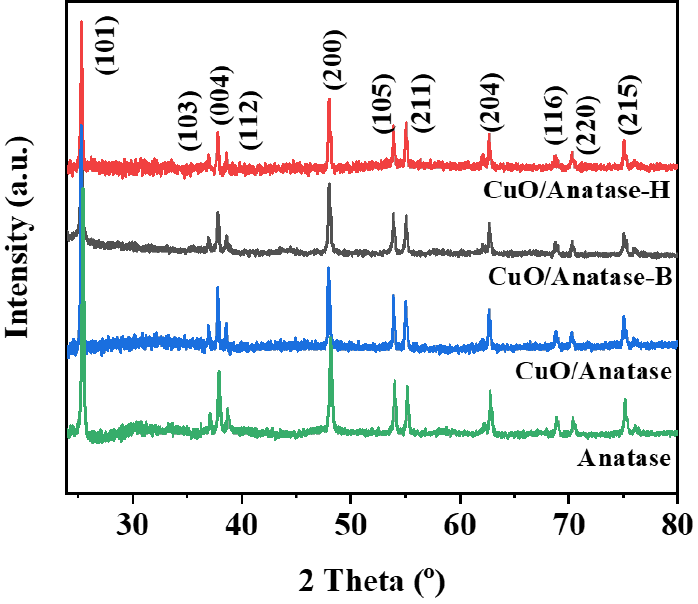
Figure 1. The XRD patterns of anatase, CuO/anatase, CuO/anatase-B and CuO/anatase-H catalysts.